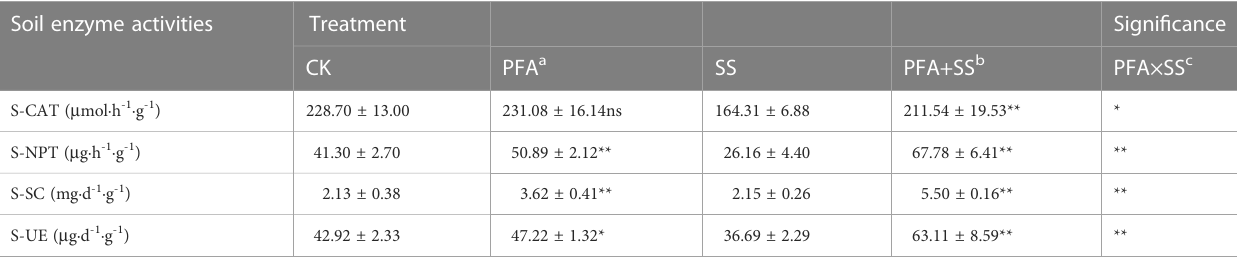
TABLE 2 Effect of PFA on the rhizosphere soil enzyme activities of the seedlings. Soil enzyme